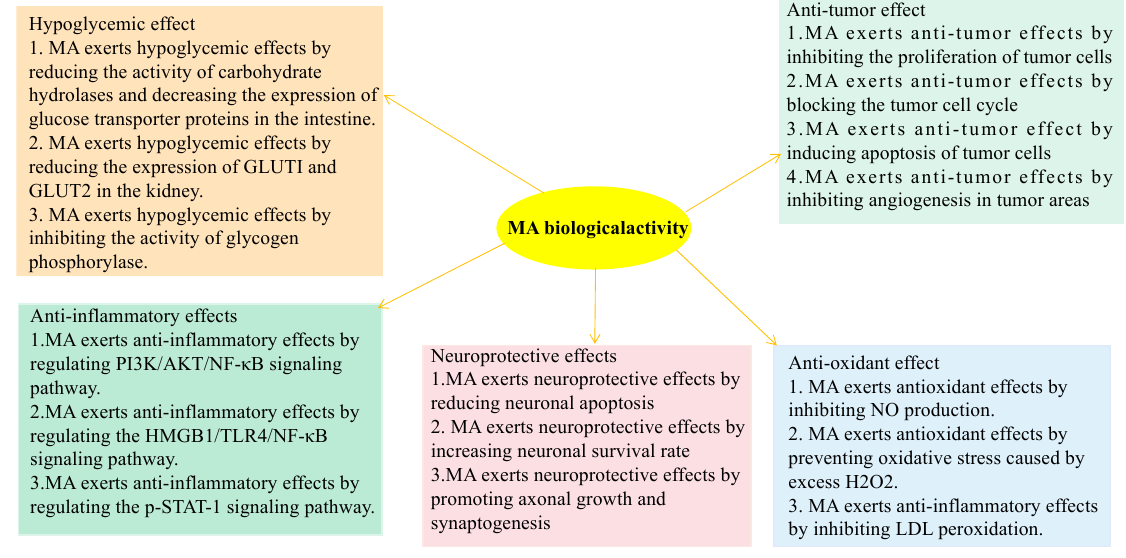
Figure 3. Biological activity of MA.